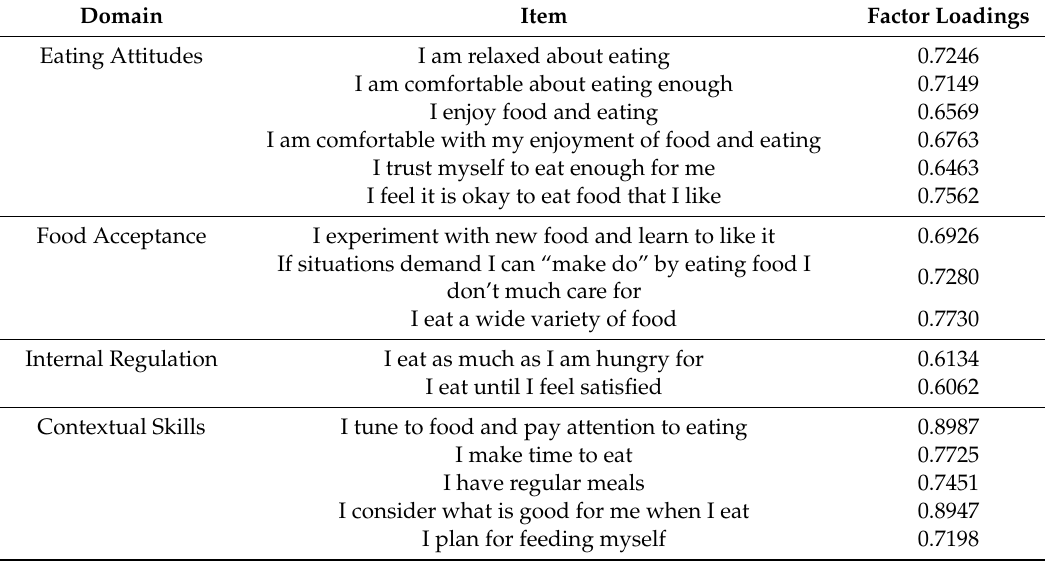
Table 4. Standardized regression weights between domains and individual items of the ecSI2.0 TM